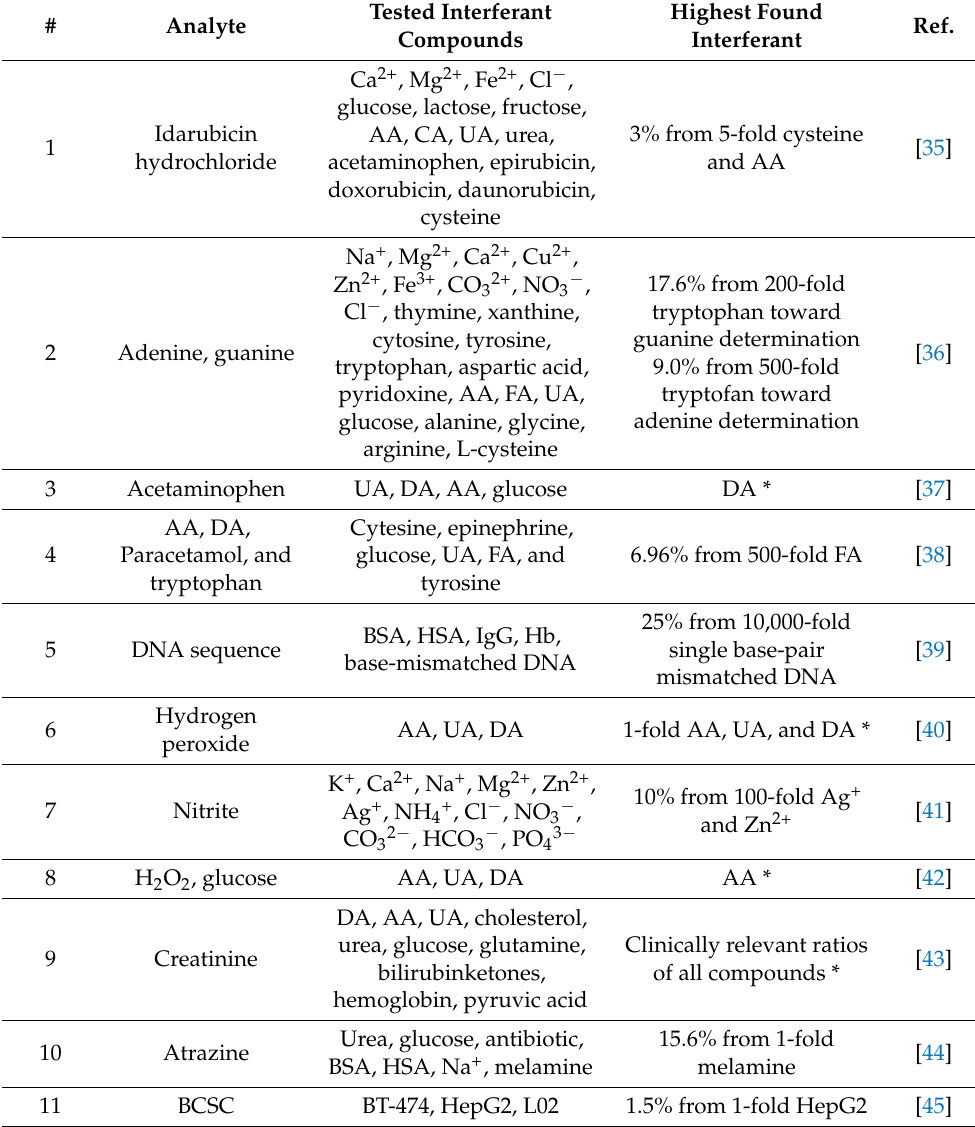
Table 2. Summary of control interferant experiment data for various nanofiber-based electrochemical sensors. The # corresponds to the same designation number in Table